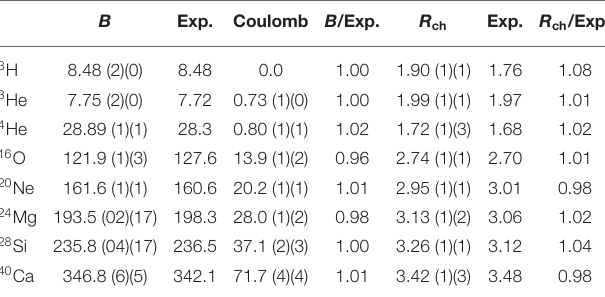
TABLE 2 | Left side: Computed binding energies of several nuclei compared with experimental values.